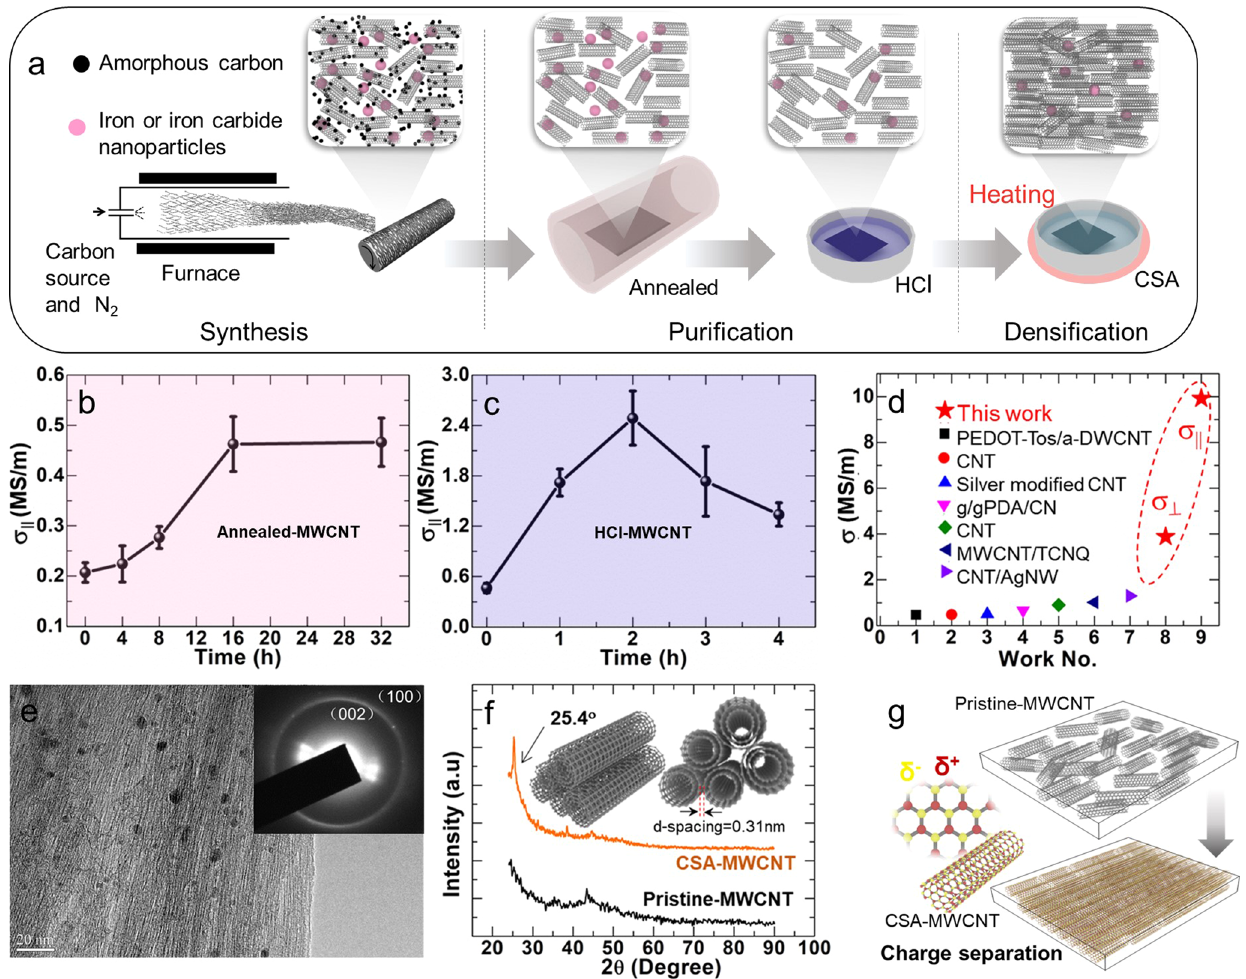
Fig.1|MWCNT fi lmpreparationprocessandbasicpropertiescharacterization. a IllustrationoftheMWCNT fi lmsynthesisandtreatmentprocesses. b The σ || ofthe MWCNT fi lm as a function of the annealing time, concentrated HCl treating time ( c ). d Compared the maximum σ || and σ ⊥ to the σ of CNT fi lm reported in